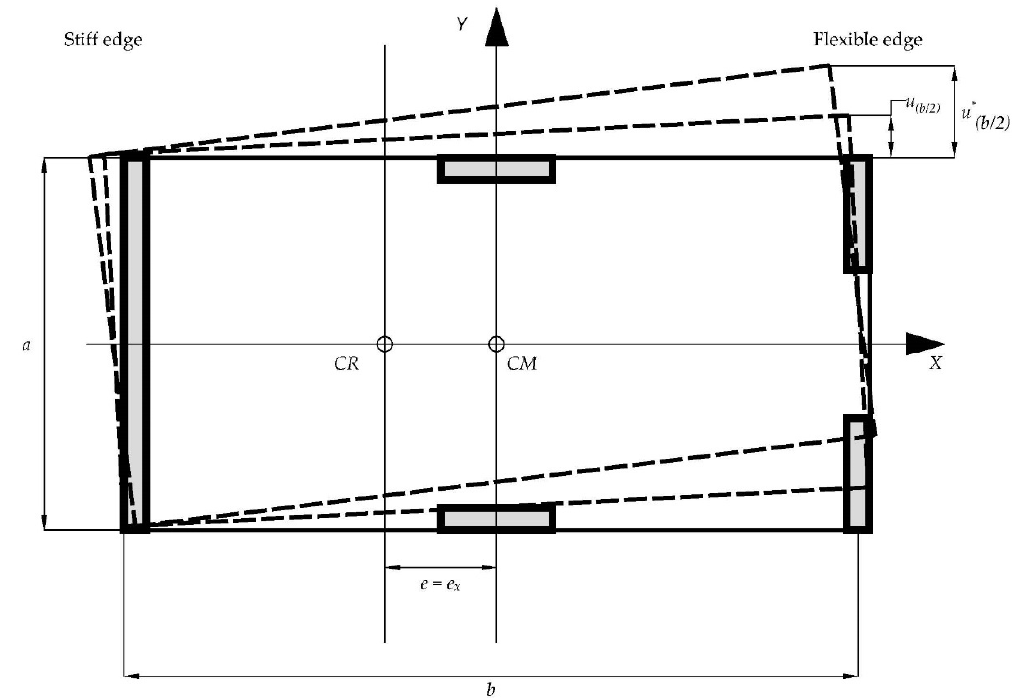
Figure 1. Typical single eccentric system showing center of mass ( CM ) and eccentric center of rigidity ( CR ).